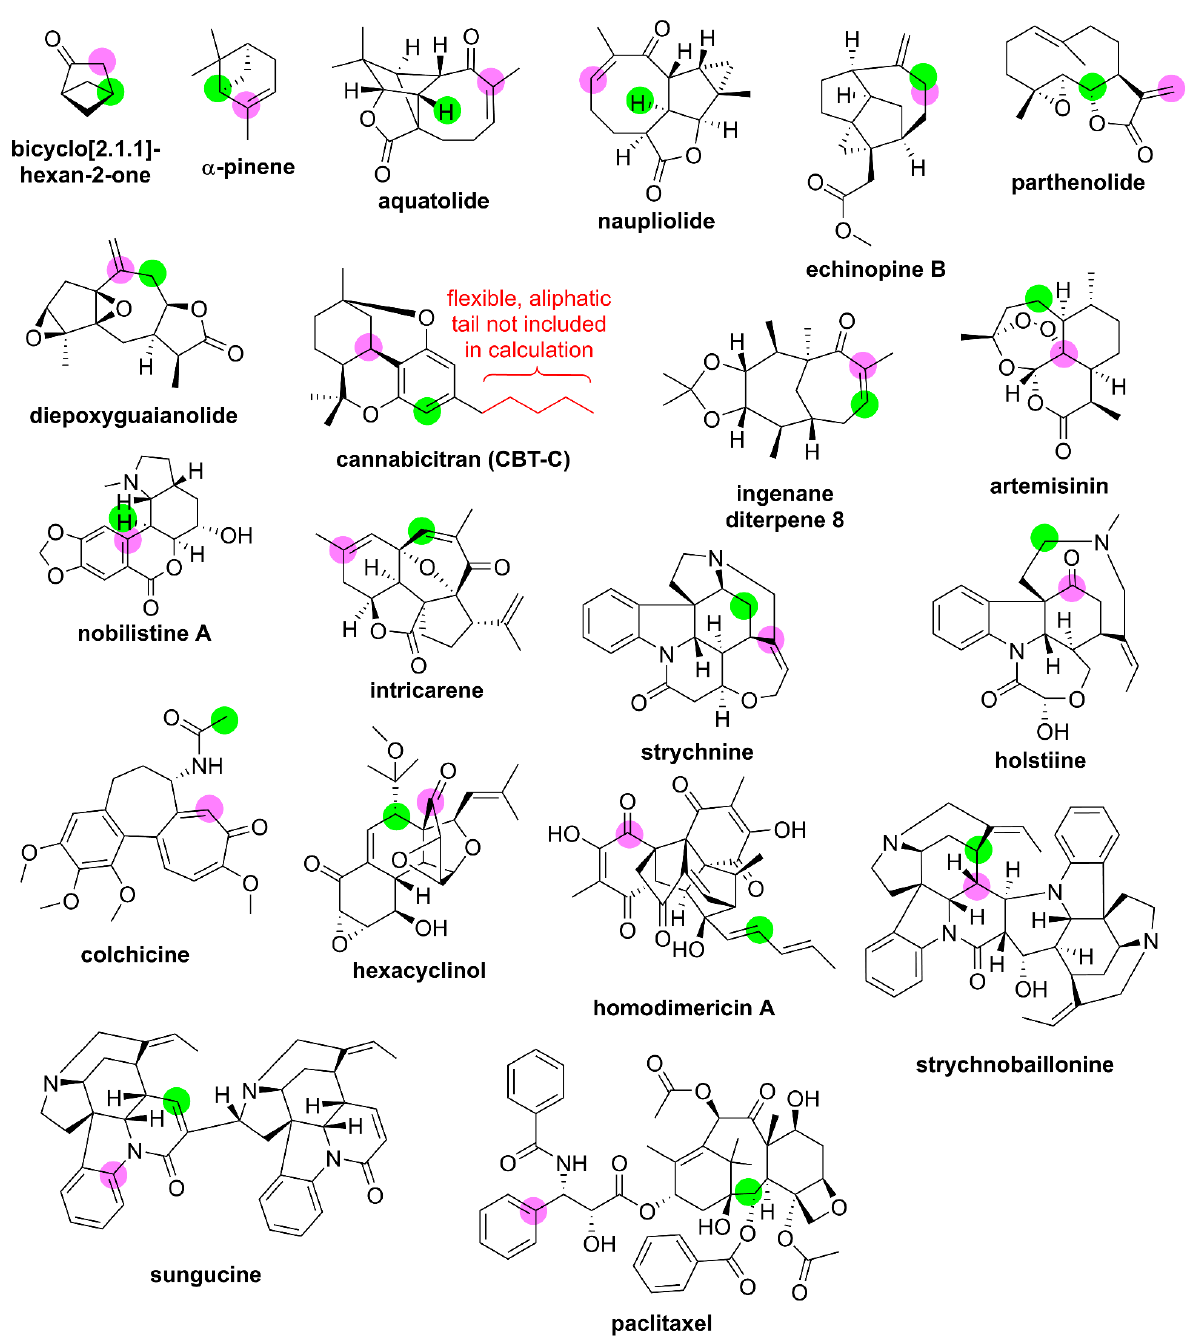
Figure 6. Probe set structures. Atomic locations of maximum chemical shift deviations compared to experiment for method two calculations from this study are highlighted for δ C and δ H in magenta and lime green, respectively.